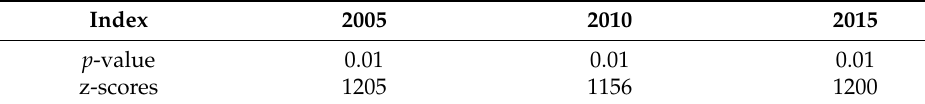
Table 5. The significance analysis index of YRD in 2005, 2010, and 2015.